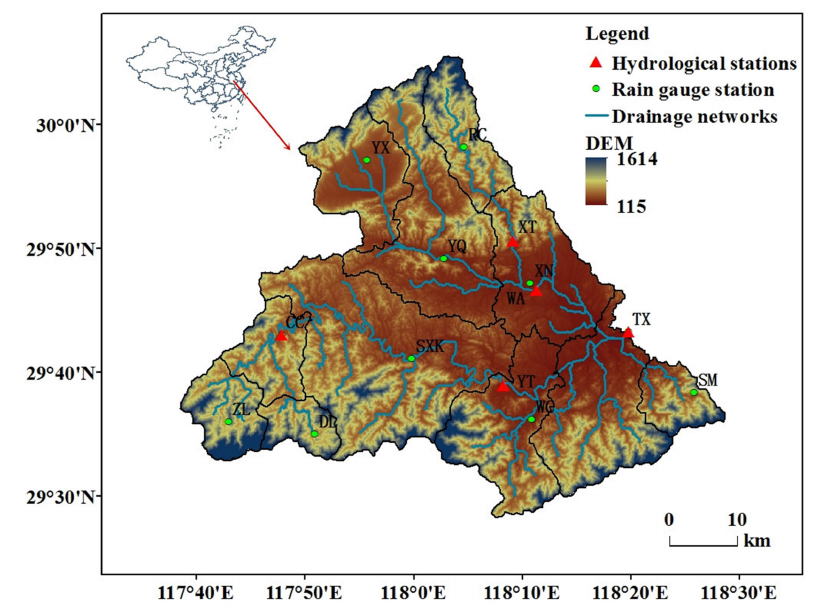
Figure 3. Map for the study catchments and locations of the rain gauges.